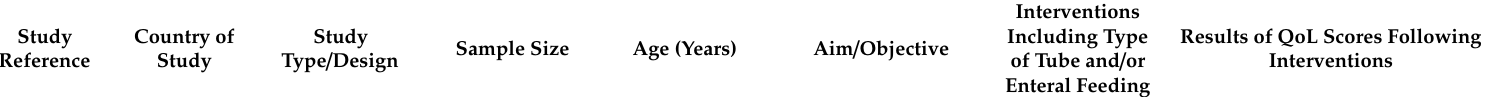
Table 2. Characteristics of the articles included in this review (N =